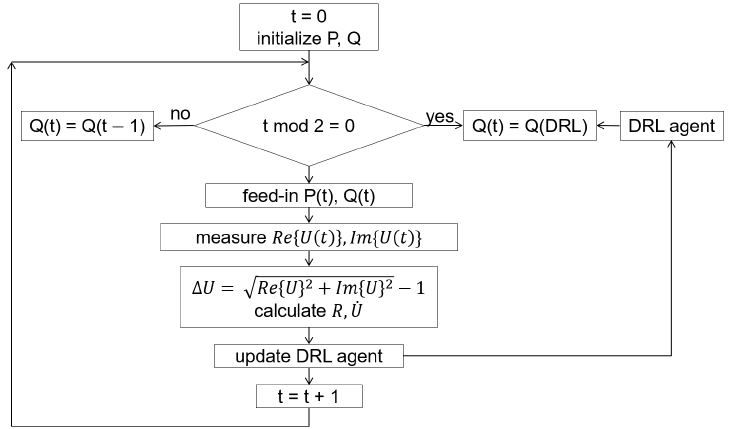
Figure 1. Flowchart of the proposed deep reinforcement learning volt-var